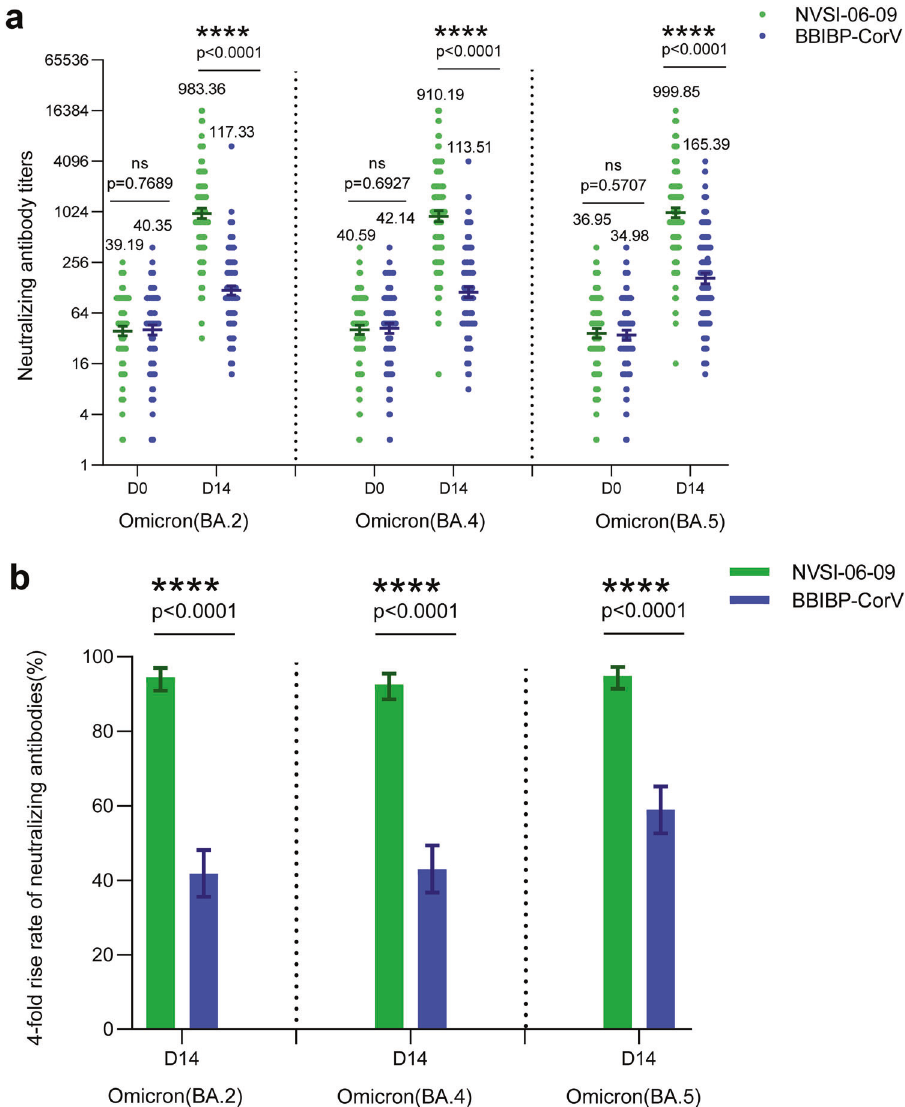
Fig. 4 The cross-neutralizing antibody titers, along with the corresponding four-fold rise rate, against Omicron BA.2, BA.4, and BA.5 induced by the booster vaccination of NVSI-06-09, compared with those boosted with BBIBP-CorV. a The anti-BA.2, anti-BA.4, and anti-BA.5 neutralizing antibody titers at baseline and on day 14 after booster vaccination. Data are presented as GMTs and 95% CIs. b The corresponding four-fold rise rate of neutralizing antibodies from baseline and 95%CIs on day 14 after the booster. ****: p < 0.0001, ns not signi fi